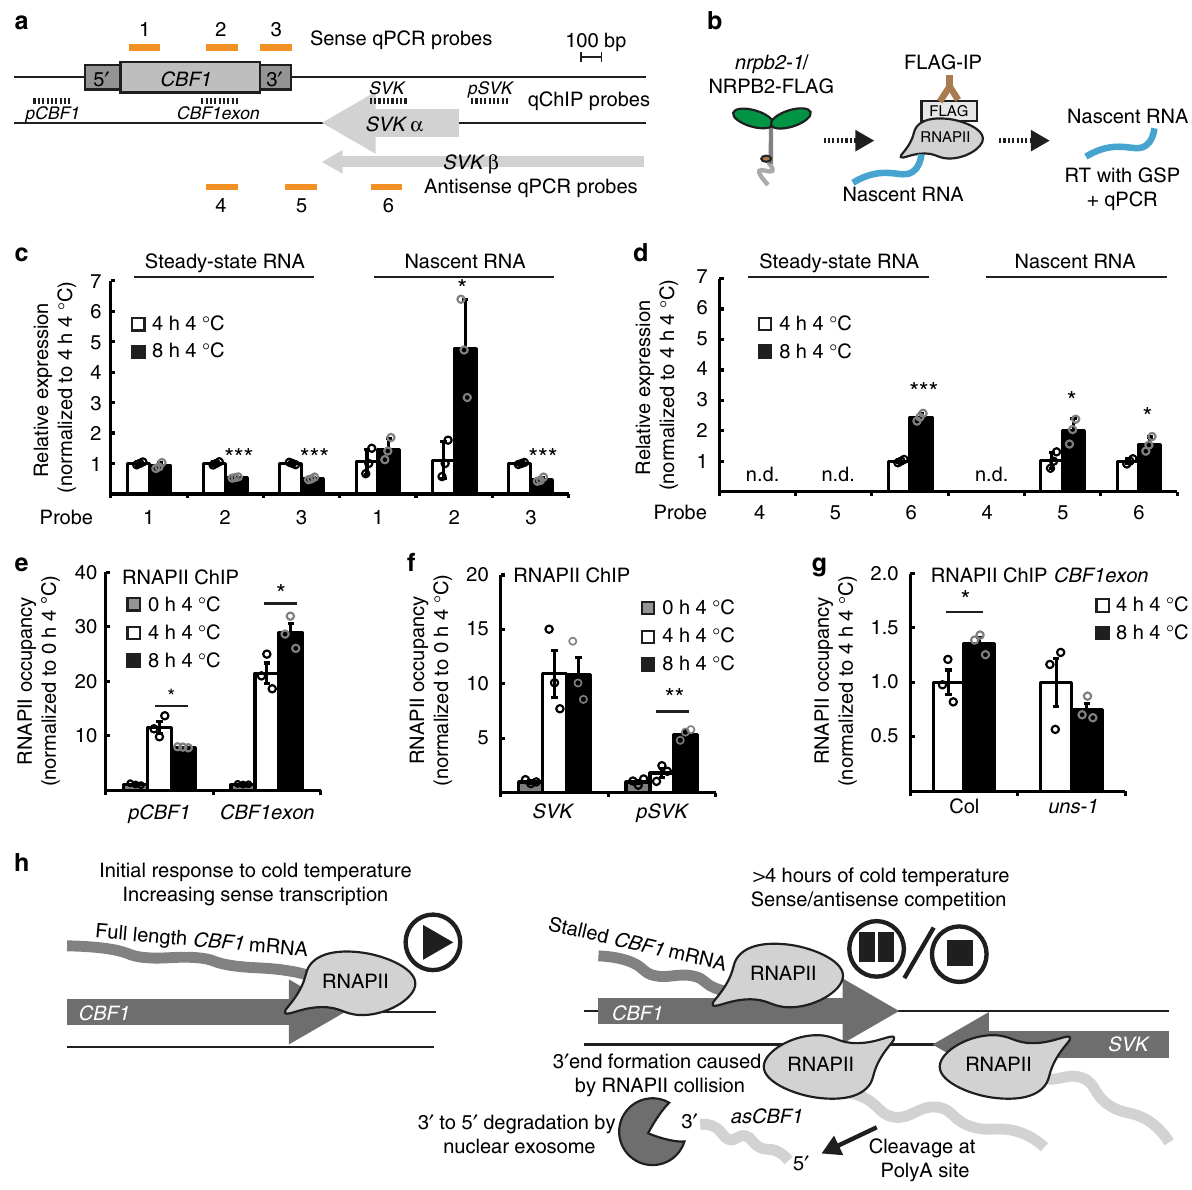
Fig. 5 Antisense transcription to CBF1 results in stalling mRNA transcription at the 3 ′ -end of CBF1 . a Graphical representation of the sense and antisense qPCR probes used in c and d . RT was done with an oligo-linked primer to ensure strand-speci fi city. qChIP probes used in e – g are indicated with a dashed black line. b Graphical visualization of the RNAPII-IP to isolate nascent RNA. c – d ) RT-qPCR with the sense probes (1 – 3, c ) and with the antisense probes (4 – 6, d ). All probes are shown in a . Nascent RNA was compared to a total RNA preparation (steady-state level of RNA). Bars represent mean (white: 4 h 4 °C, black: 8 h 4 °C, ±SEM) from three biological replicates (rings). The relative level of transcripts was normalized to the level at 4 h 4 °C. Statistically signi fi cant differences between 4 and 8 h of 4 °C were determined with Student ’ s t-test (* p < 0.05, *** p < 0.001). Source data are provided as a Source Data fi le. e – g qChIP of total RNAPII along the CBF1 genomic region following cold exposure in WT ( e ), of the SVK genomic region in WT ( f ) and of the CBF1 transcription unit in WT and the uns-1 mutant following 4 and 8 h of 4 °C ( g ). The location of promoter ( pCBF1 ), CBF1 exon, the promoter ( pSVK ) and SVK probes can be seen in a . Bars represent the mean of three biological replicates (grey: 0 h 4 °C, white: 4 h 4 °C, black: 8 h 4 °C, ±SEM) and are normalized to the level at 0 h 4 °C. Statistically signi fi cant differences were determined with Student ’ s t -test (* p < 0.05, ** p < 0.01, *** p < 0.001). Source data are provided as a Source Data fi le. h Mechanistic model of how transcription of SVK represses sense CBF1 transcription. Initially during cold exposure, SVK is not expressed and sense CBF1 can be transcribed without hindrance (left panel). CBF1 expression peaks after 4 h of cold exposure. Simultaneously, expression of the lncRNA SVK is increased in the antisense direction of CBF1 (right panel). Read-through transcription of SVK results in transcription antisense to the 3 ′ -end of CBF1 and an increase of RNAPII occupancy on both strands. The intensi fi cation of transcribing polymerases in both directions creates RNAPII collision and stalling of CBF1 sense transcription. The outcome of the collision is that fewer RNAPII complexes reach the end of the